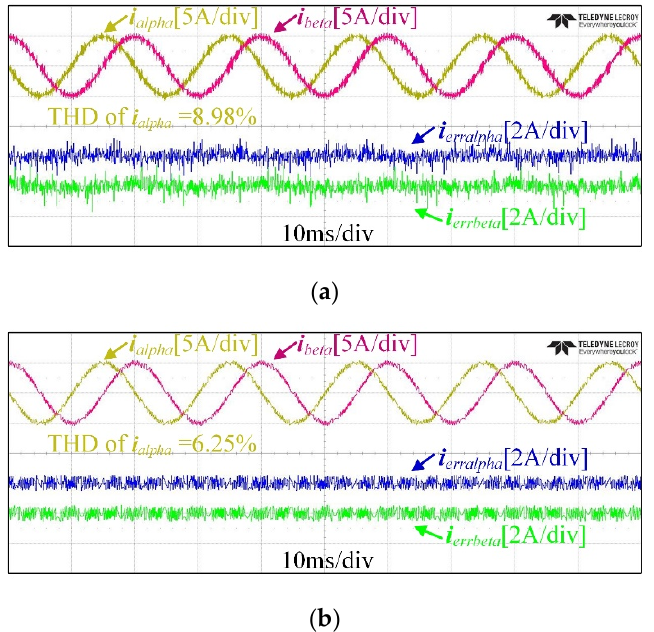
Figure 11. Experimental waveforms comparisons when L / L 0 = 0.5 ( i ref = 5A). ( a ) Waveforms under the conventional MPC scheme. ( b ) Waveforms under the proposed MFPC scheme.